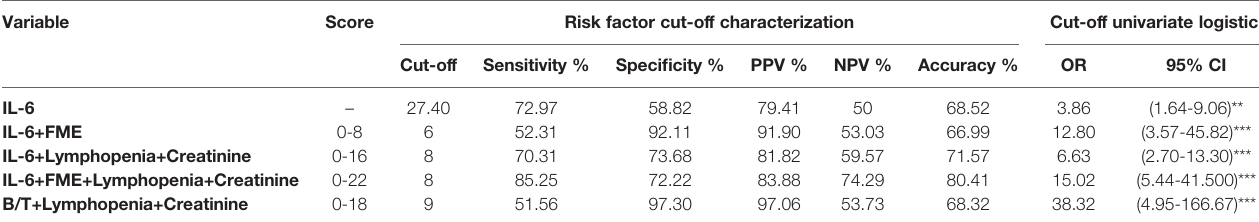
TABLE 4 | Univariate logistic regression analyses of IL-6 signalling components as predictors of COVID-19 mortality based on proposed scores. Variable